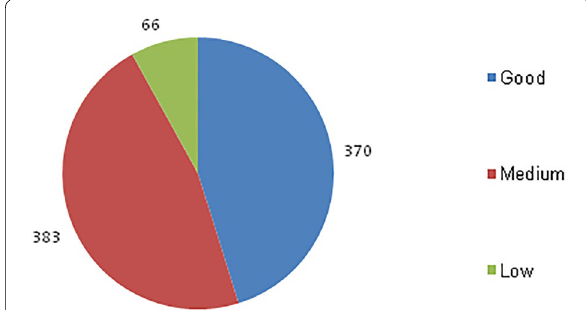
Fig. 5 Incompatible buildings by state of conservation. Detailed Urban Plan Data. In absolute numbers